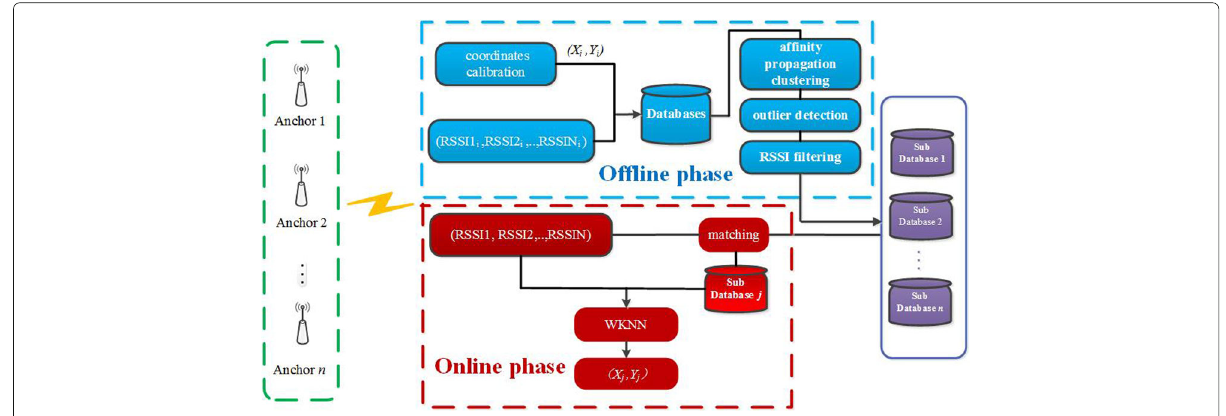
Fig. 2 Process of BLE fingerprint